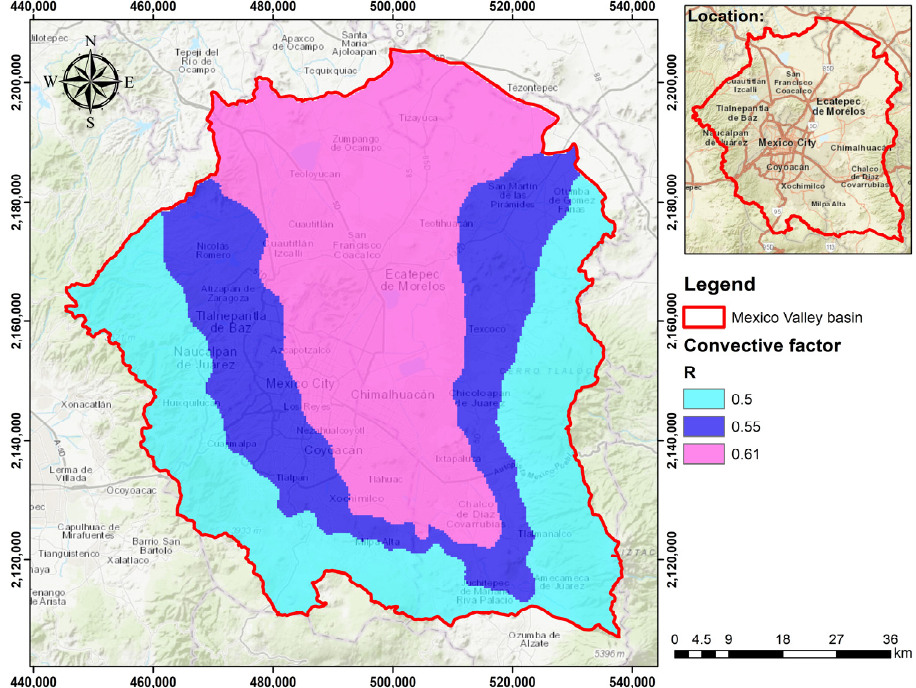
Figure 5. Convective factor R Map for Mexico Valley River Basin. “Adapted from Ref. [21], 2022,